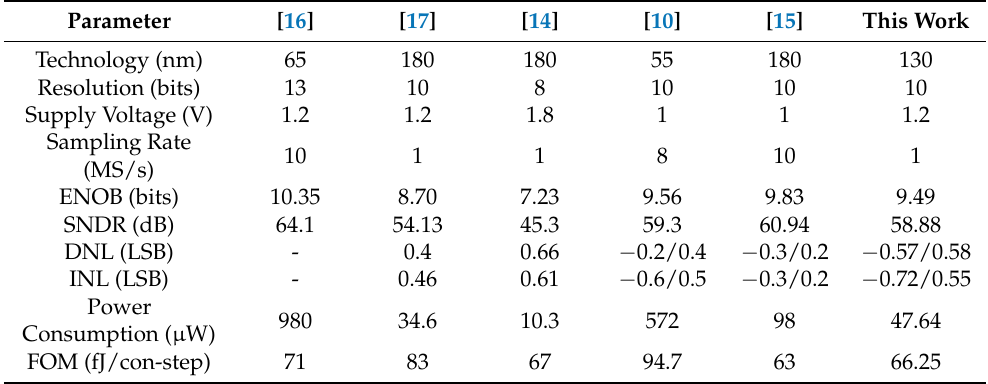
Figure 16. ( a ) Measured ENOB trend at different input frequencies with 1 MS/s sampling speed; ( b ) Power breakdown of proposed ADC. Table 1. Performance summary and comparison table.